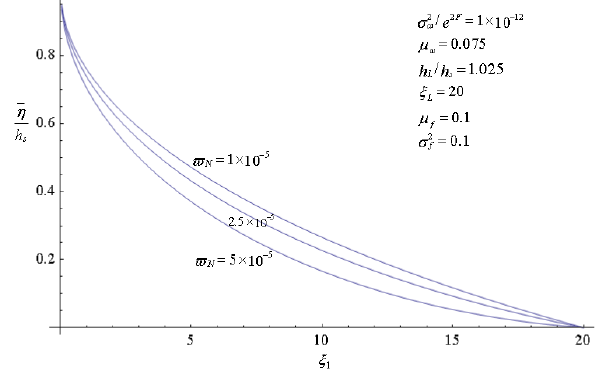
Fig. 3. Dimensionless mean elevation of seawater-freshwater in- terface as a function of dimensionless position for various values of $ N .